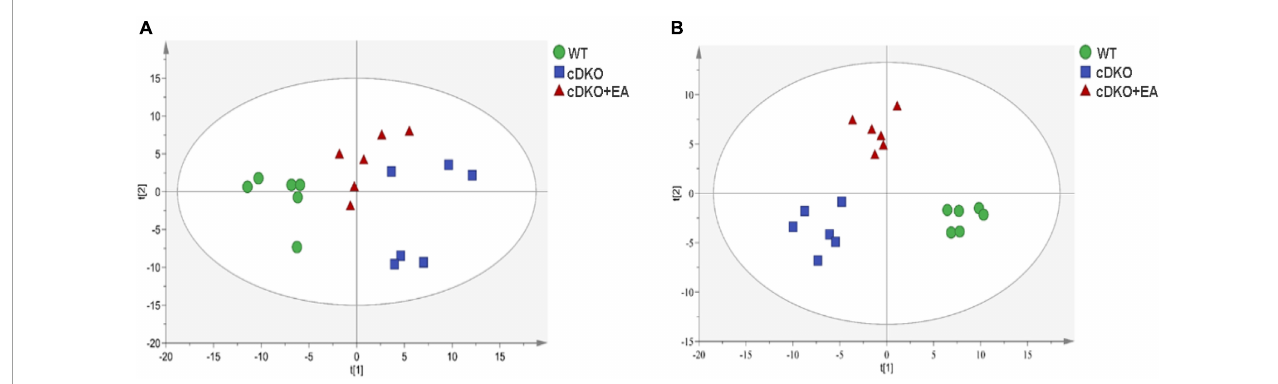
FIGURE2 Scores plots of multivariate statistical analysis on urinary metabolites. PCA scores plot (A) and PLS-DA scores plot (B) of the WT, cDKO, and cDKO + EA groups. N = 6.